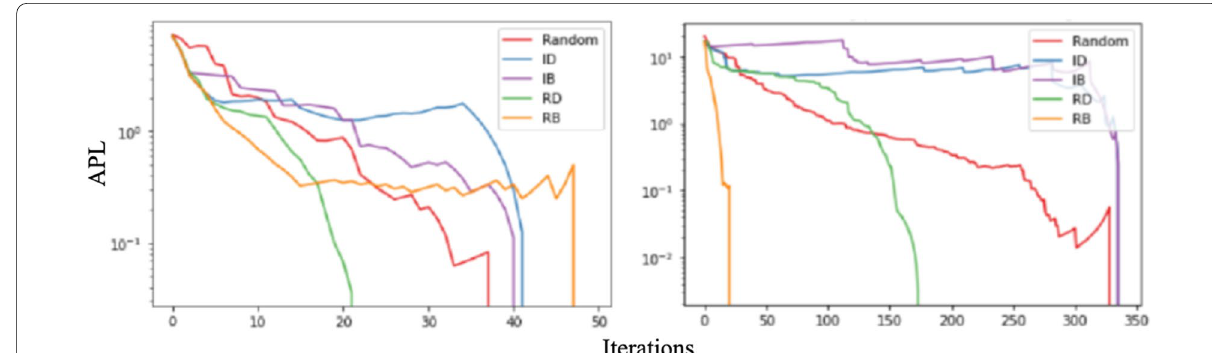
Fig. 10 Evolution of APL along node extraction strategies for METRO (left) and SULFERTAGUS (right)